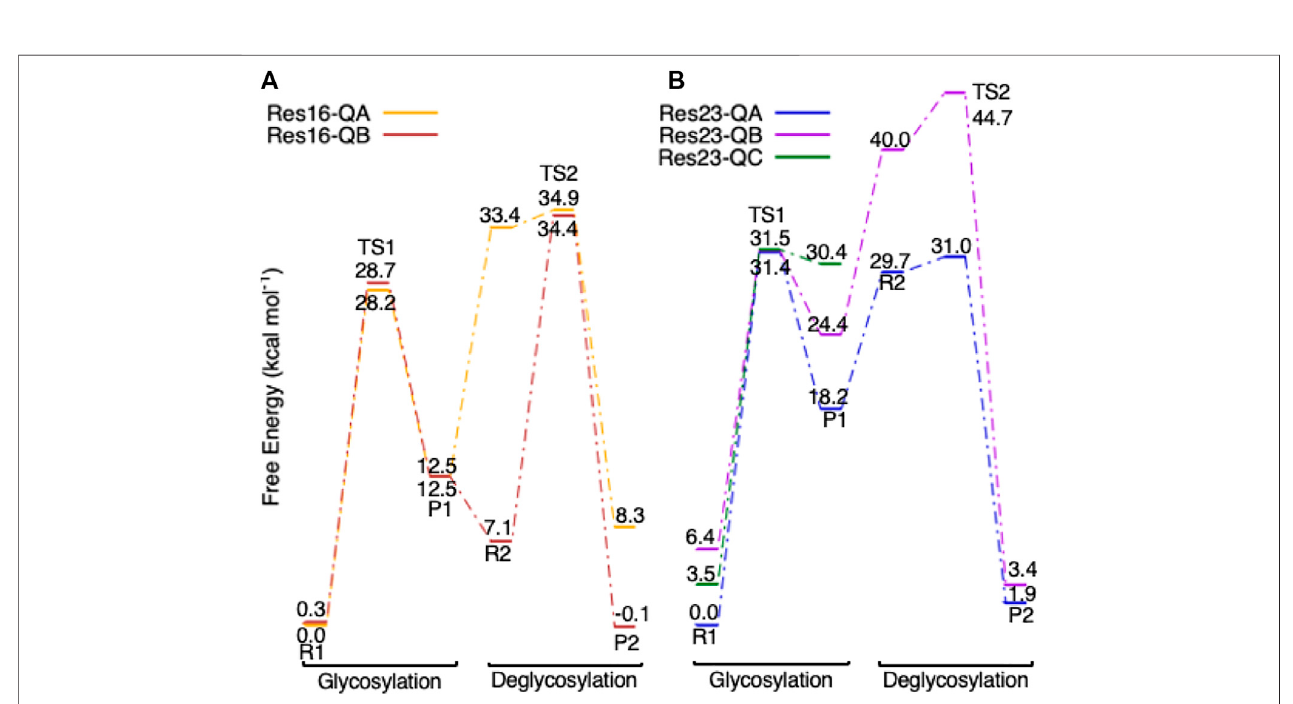
FIGURE 12 | Free energy diagram of glycosylation and deglycosylation for different conformers of models (A , left) Res16-Q and (B , right) Res23-Q based on 4C4C.